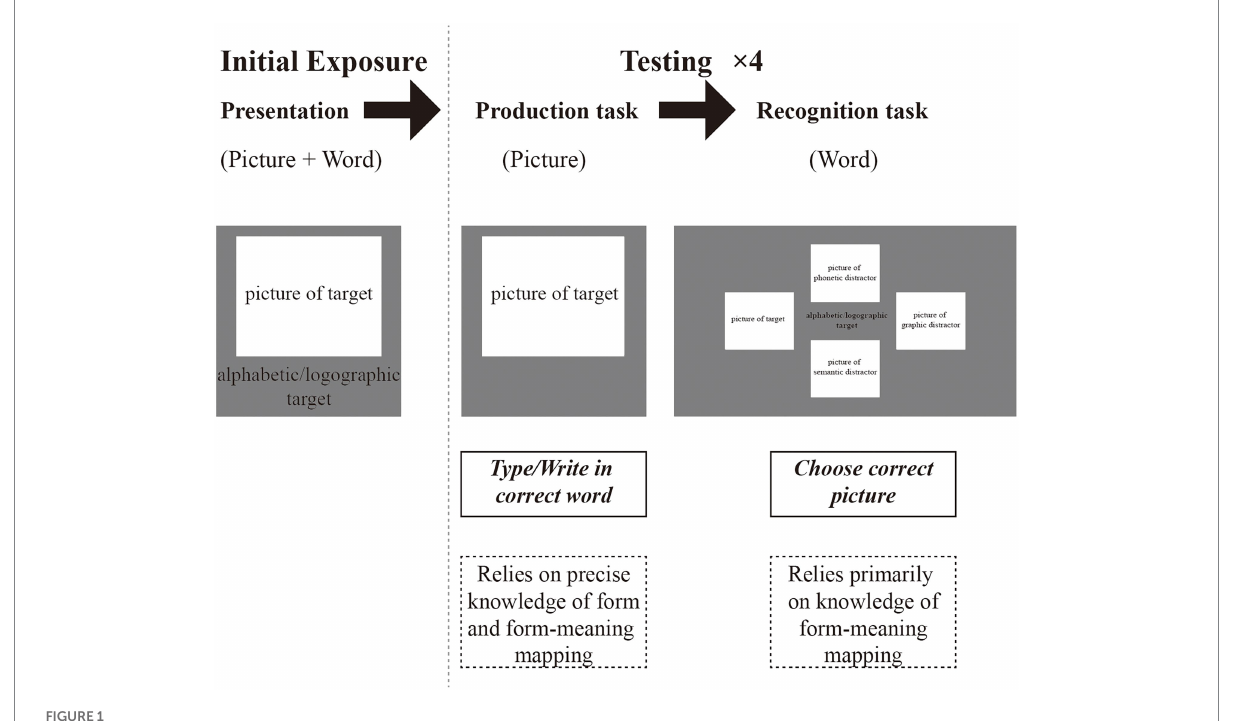
FIGURE 1 A schematic overview of the paradigm